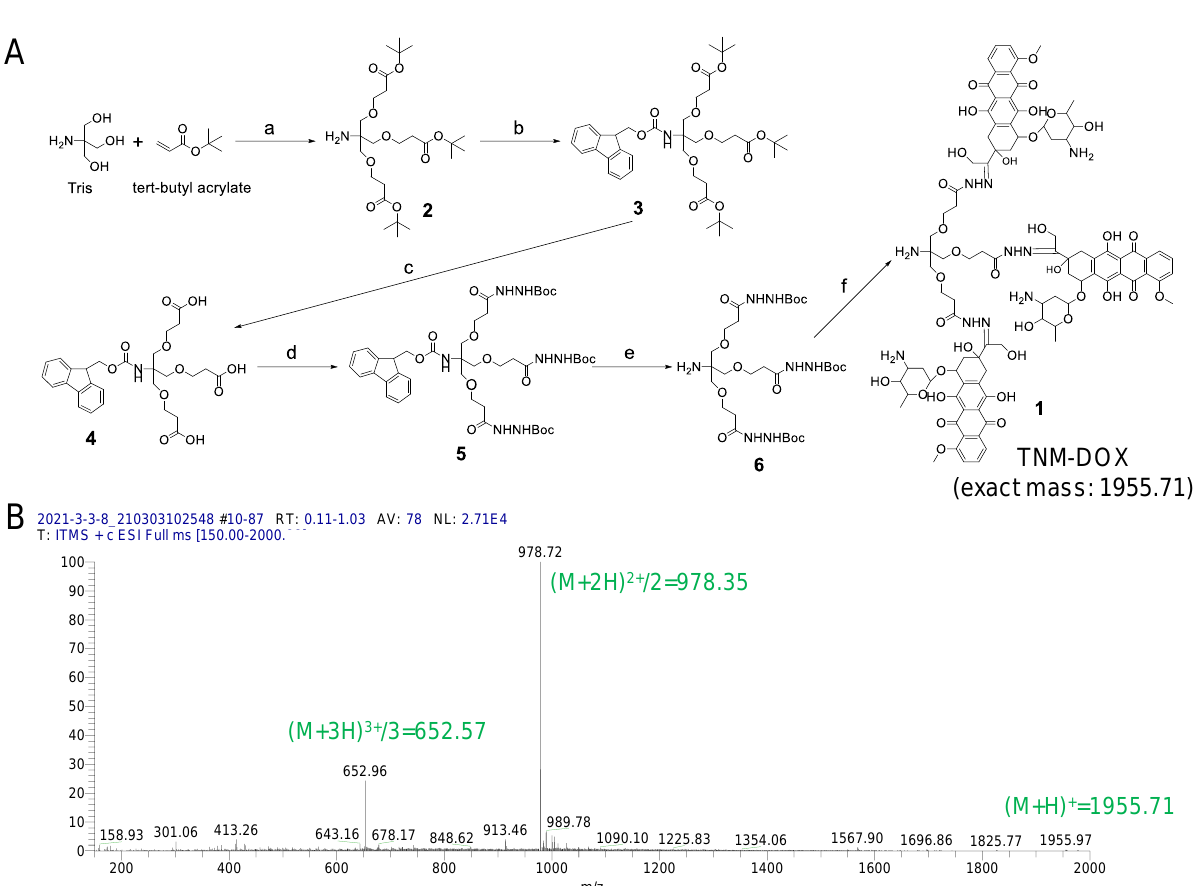
Figure 2. Synthesis of TNM-DOX. ( A ) The scheme of TNM-DOX synthesis. Reagents and conditions: (a) DMSO, 5 M NaOH, RT, 24 h; (b) Fmoc-Cl, DCM, NMM, RT, 1 h; (c) TFA/water = 95/5, RT, 90 min; (d) HBTU, DIEPA, DCM, tert-butyl carbazate, RT, overnight; (e) piperidine/DCM, RT, 1 h; (f) (1) TFA/DCM (1/1), RT, 30 min; (2) MeOH/AcOH/Pyridine (10/0.1/0.1), DOX, RT, overnight. ( B ) Mass Spectrum of TNM-DOX. MS (ESI): [M+H] + = 1955.7, [M+2H] 2+ /2 = 978.4, [M+3H] 3+ /3 = 652.6. (DMSO = Dimethyl sulfoxide, Fmoc-Cl = Fluorenylmethyloxycarbonyl chloride, DCM = Dichloromethane, NMM = N- Methylmorpholine, RT = room temperature, TFA = Trifluoroacetic acid, HBTU = N,N,N′,N′ -Tetramethyl-O-(1H-benzotriazol-1-yl) uronium hexafluorophosphate, DIPEA = N,N-Diisopropylethylamine, MeOH = Methanol, AcOH = Acetic acid, DOX = Doxorubicin).